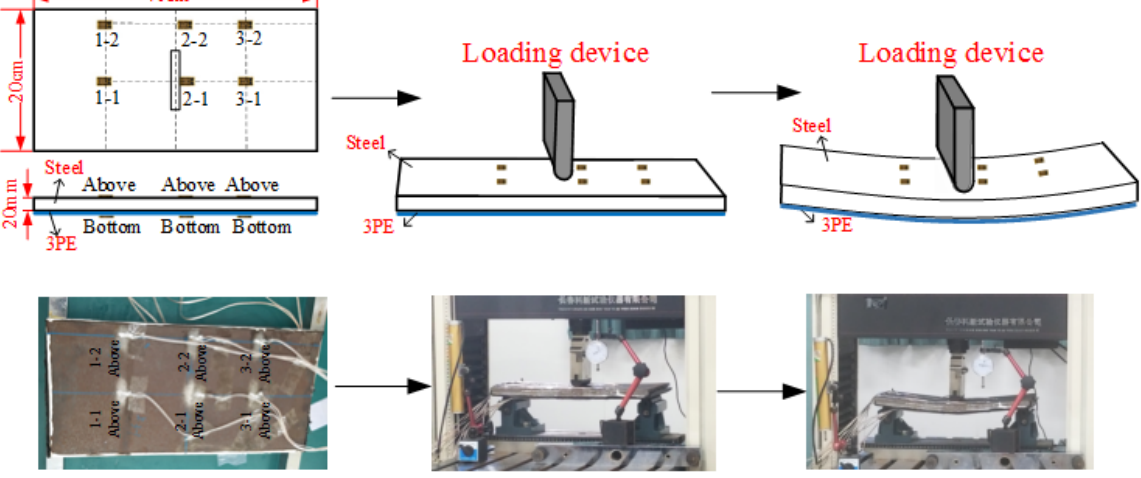
Figure 3. Laboratory test drawing of steel-3PE.